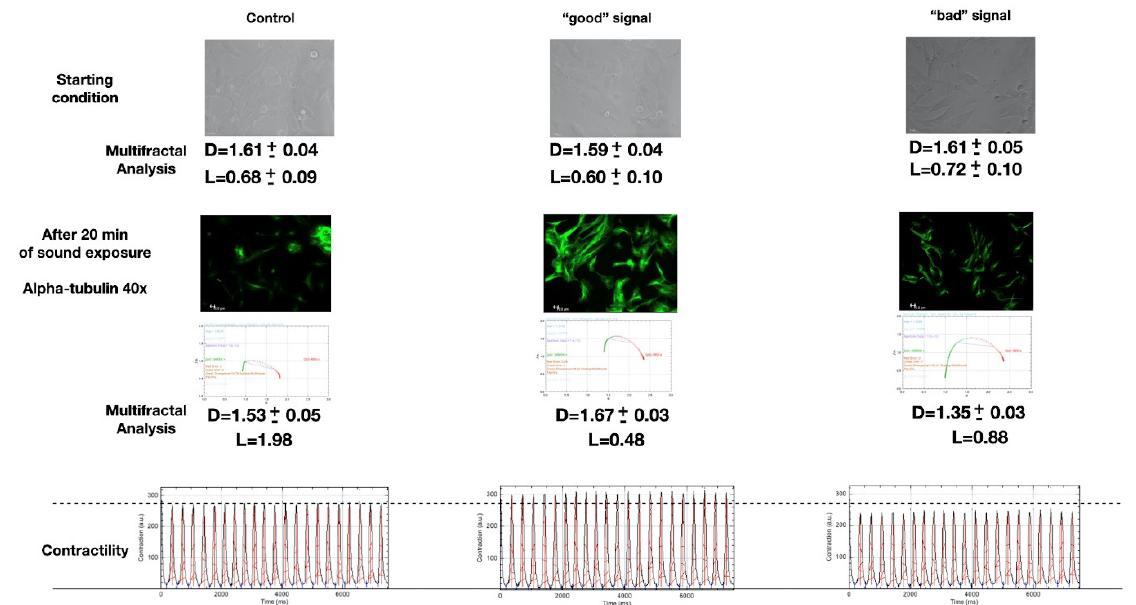
Figure 1. (Modified from [8]). The first row shows the starting condition using bright-field images (representative images selected from 5 positions and 6 experimental repetitions). The cells have a basal multifractal arrangement characterized by an average fractal size (D) of about 1.6 and a lacunarity (L) of 0.7. Scale: 10 µ m. The middle row represents the result of the different sound stimulations. Alpha-tubulin was marked in green. In the control cells, there were no significant variations in the parameters D and L. In the case of “good” sounds, there was an increase in the D to 1.7 and a decrease in the L to 0.4. In the case of “bad” signals, the D reduced to 1.3 with a slight increase in the L to 0.8. Scale: 10 µ m. The lower row shows the contractility analysis of the same cell under the different acoustic stimulations.